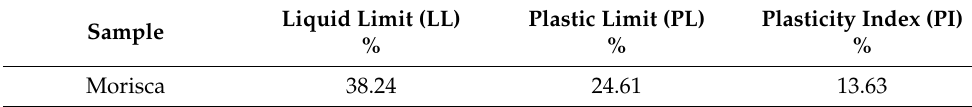
Table 4. Plasticity index of the morisca sample.